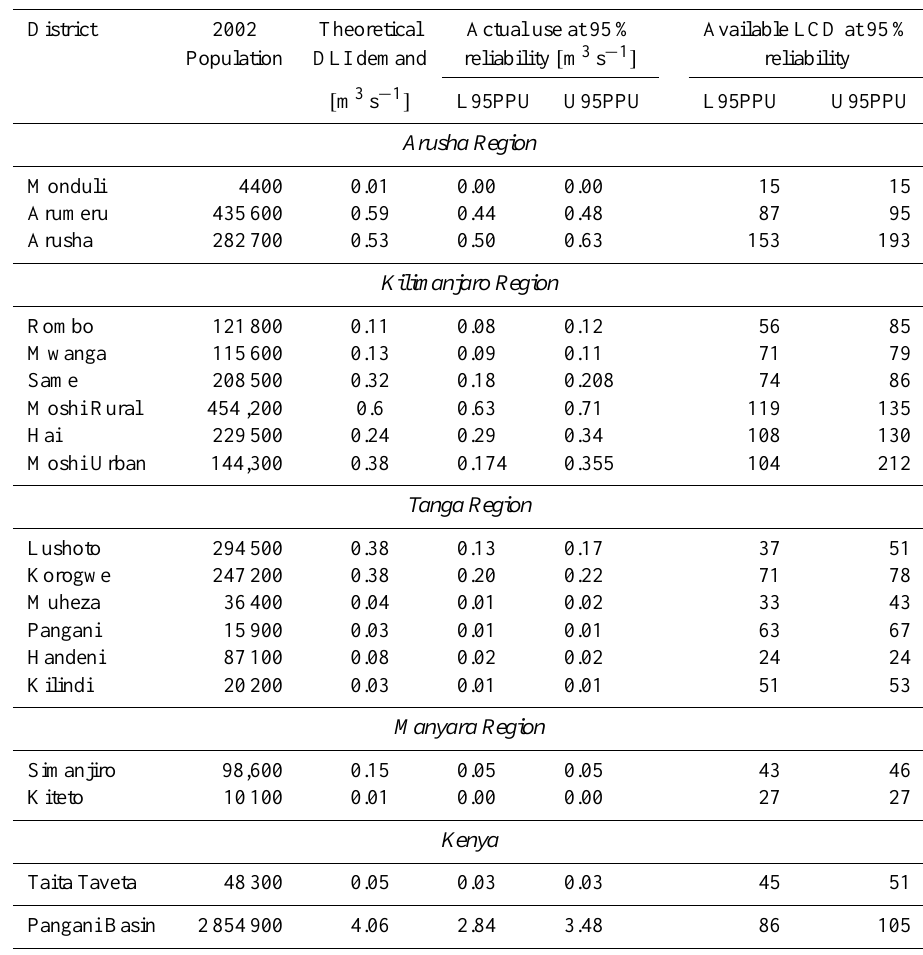
Table 4. Water provision for domestic, livestock and industrial (DLI) use by District in the Pangani Basin. Upper (U95PPU) and lower (L95PPU) boundaries of the 95% prediction uncertainty are